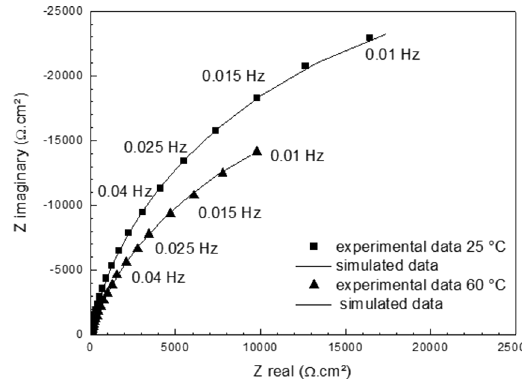
Figure 10. Nyquist diagram of TiAlN/TiAlCrN coated Ti–6Al–4V alloy in 2 M NaOH at 25 and 60 °C.